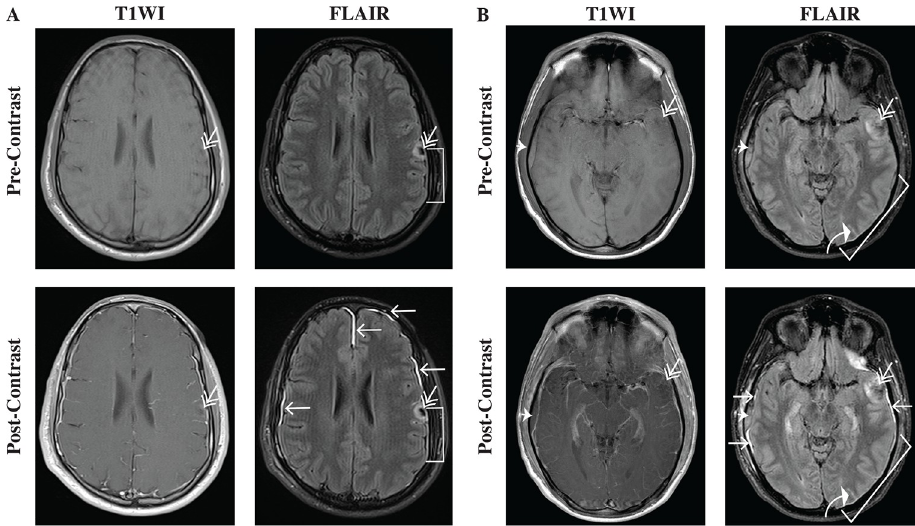
Fig 1. T1WI and FLAIR pre- and post-contrast MRI can reveal different types of TBI-related pathology in patients presenting acutely ( < 48 hours) after injury. Radiological conventions are used here, with the patient’s left side on the right-hand side of the image. (A) The first series of images shows a representative example of a TBI patient with a contusion (double arrow), a subdural hematoma (bracket), and traumatic meningeal enhancement (TME) (single arrows). On both T1WI pre- and post-contrast images, the small contusion on the patient’s left side is more noticeable on FLAIR images secondary to associated edema. The pre-contrast and post-contrast FLAIR demonstrate a thin subdural hematoma adjacent to the contusion, which is not readily apparent on the T1WI images. On post- contrast FLAIR, areas of TME are also evident. In comparison, the T1WI post-contrast imaging reveals mostly vascular patterns in the parenchyma and along the meninges. (B) The second series of images shows images from another representative TBI patient with a small contusion (double arrow), a small epidural hematoma (thick arrowhead), a thin subdural hematoma (bracket), and associated subarachnoid hemorrhage (curved white arrow), in addition to TME (single